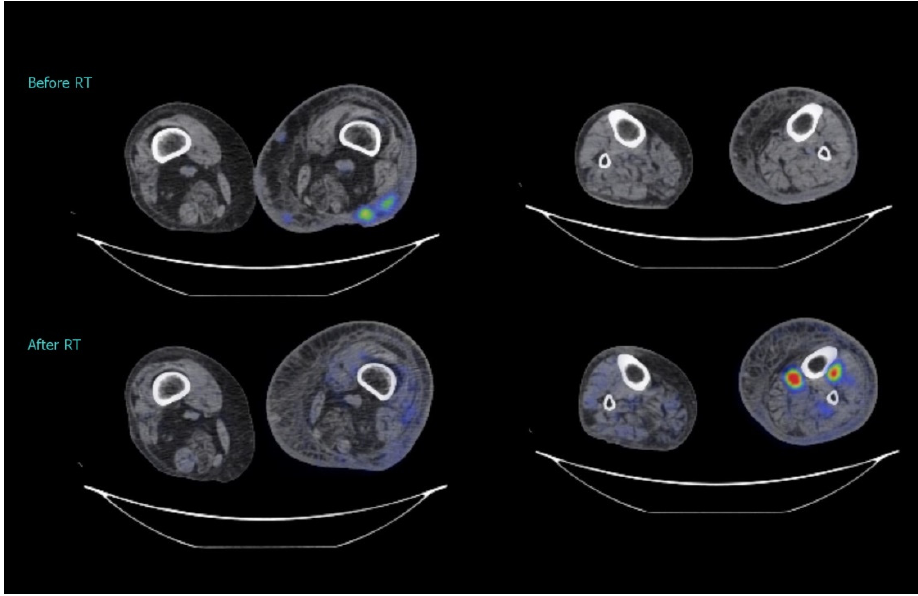
Figure 5. Comparison between 18F-FDG PET images: three months after radiotherapy several 18F-FDG-avid nodules appeared at the interface between muscles and bones. 18F-FDG PET, fluorodeoxyglucose positron emission tomography.